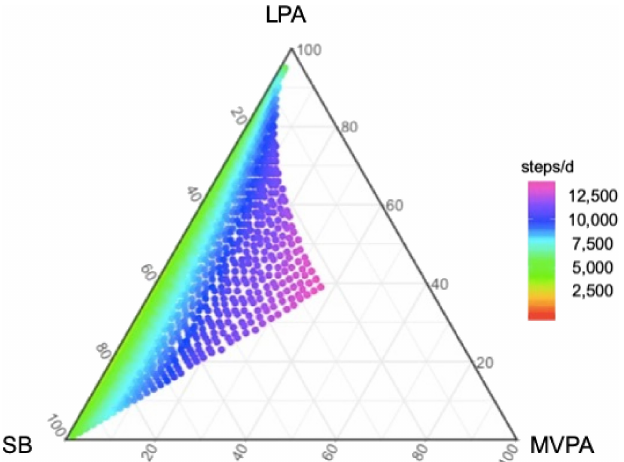
Figure 2. Estimated step count in proportion of sedentary behavior, light-intensity physical activity, and moderate-to-vigorous physical activity. LPA, light- intensity physical activity; MVPA, moderate-to- vigorous physical activity; SB, sedentary